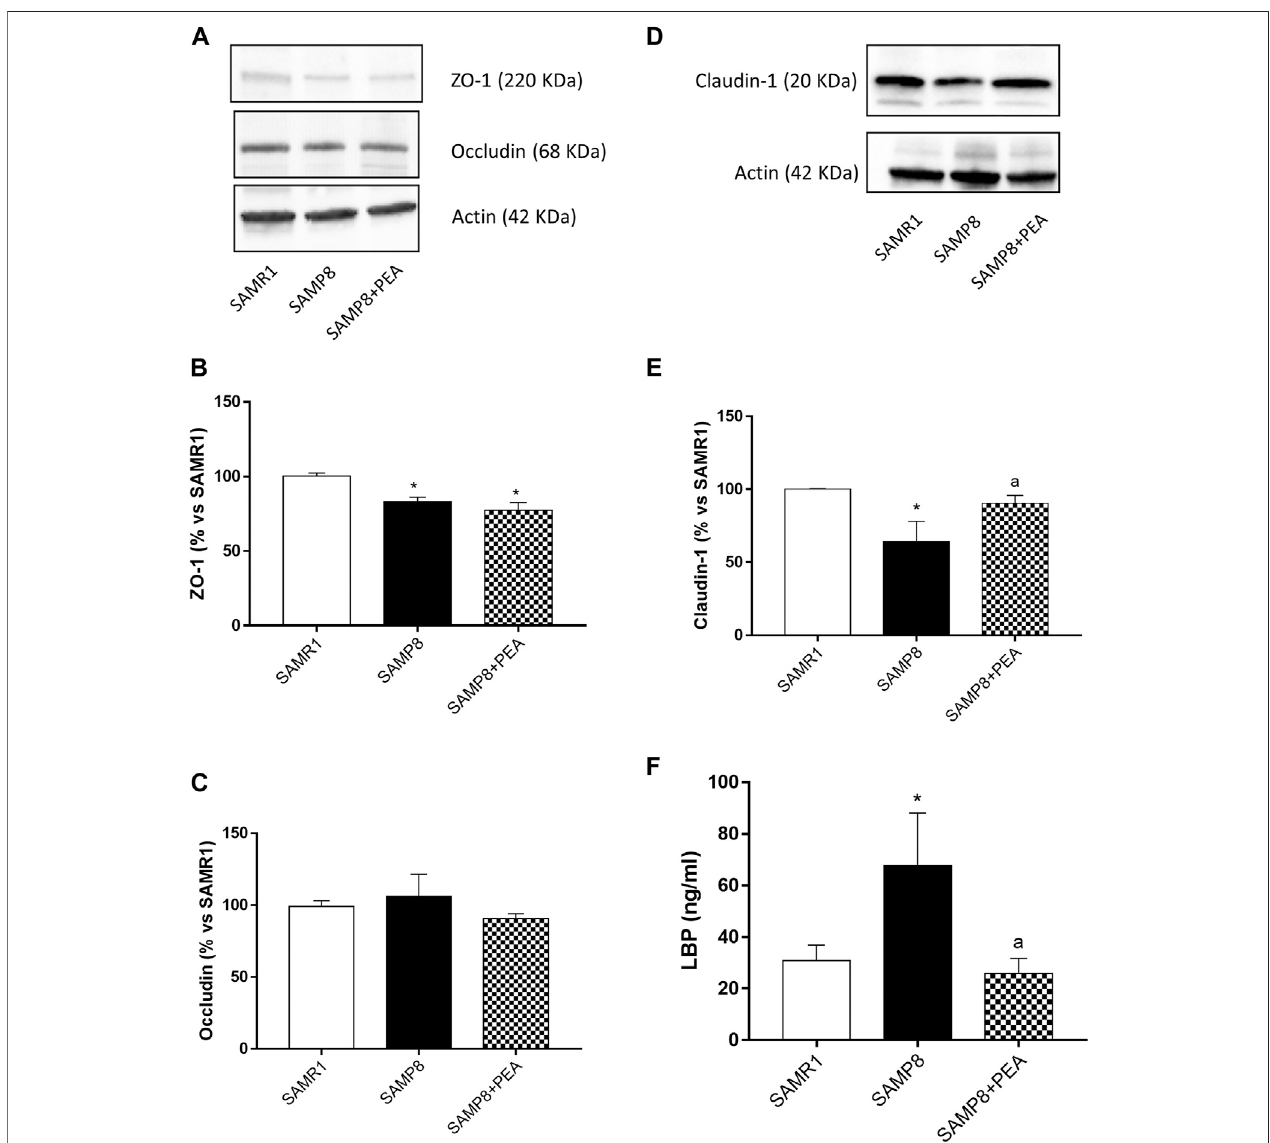
FIGURE5| PEAimprovestheintestinalepithelialbarrierintegrityinthepresenceofin fl ammation.Representativeblotsanddensitometricanalysisoftheexpression of (A, B) ZO-1, (A, C) occludin and (D, E) claudin-1 in colonic tissues from SAMR1, SAMP8 and SAMP8 treated with PEA. (F) Circulating LBP in SAMR1, SAMP8 and SAMP8 treated with PEA. Each column represents the mean ± SEM from four animals. One-way ANOVA followed by Tukey post hoc test results: * p < 0.05, signi fi cant difference vs. SAMR1 and a p < 0.05, signi fi cant differencevs. SAMP8.; Abbreviations : LBP, lipopolysaccharide-binding protein; PEA, palmitoylethanolamide; ZO- 1,